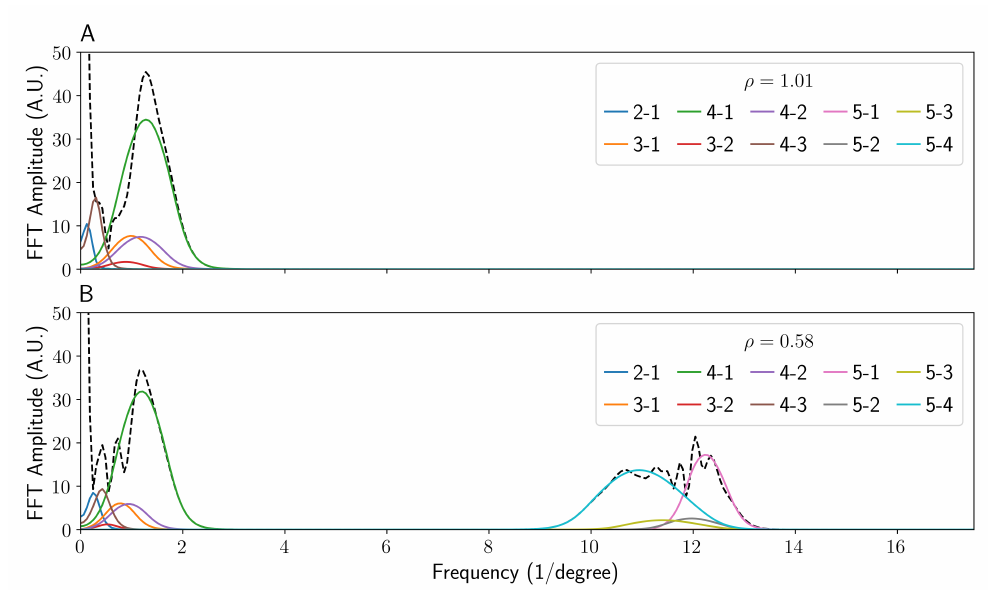
Figure 6. A graph comparing the Fourier transforms of both the high ( A ) and low ( B ) ρ values. The data were taken at 10 cm horizontally and 1 cm vertically from the capillary with a fixed camera width of 1.3 cm. The black dashed lines show the overall Fourier transforms of the patterns shown in Figure 4, with each pairwise interference term transformed and shown separately. For example, the interference between rays 1 and 2 is shown in blue and labelled 2-1. The data were windowed and zero-padded to reduce ringing and other artefacts after transformation.